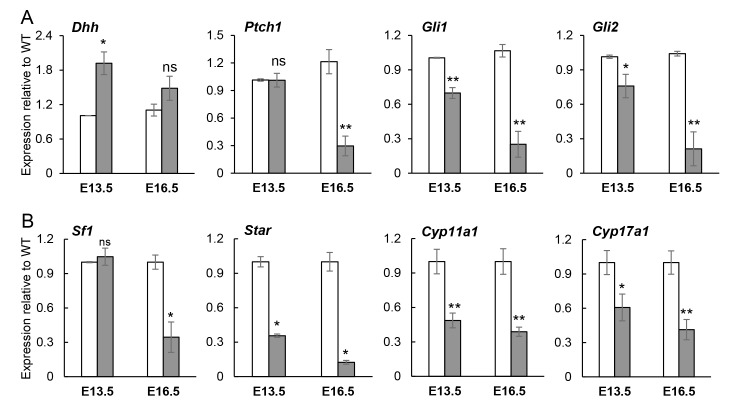
Hedgehog and steroidogenic pathway genes are decreased in Gli3XtJ testes.RT-qPCR comparing wild type (white bars) and Gli3XtJ mutant (gray bars) testis mRNA expression for hedgehog (A) and steroidogenic (B) pathway genes at E13.5 and E16.5 and expressed as fold change from wild type control at each time point and reported as the average ± SEM from n = 3–4 biological replicates. Student’s t-test, *: p<0.05, **: p<0.01, ns: non-significant.